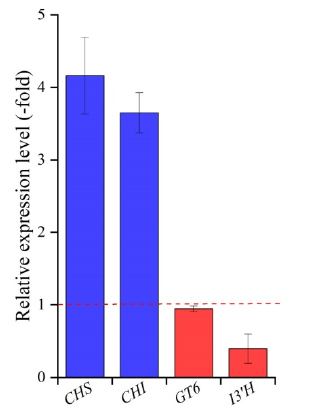
Figure 5. Expression levels of four genes related to flavonoid biosynthesis in A. sinensis . Abbrevia- tions: CHS, chalcone synthase; CHI, chalcone isomerase; GT6, UDP-glucose flavonoid 3-O-glucosyltransferase 6; I3 ′ H, isoflavone 3 ′ -hydroxylase.